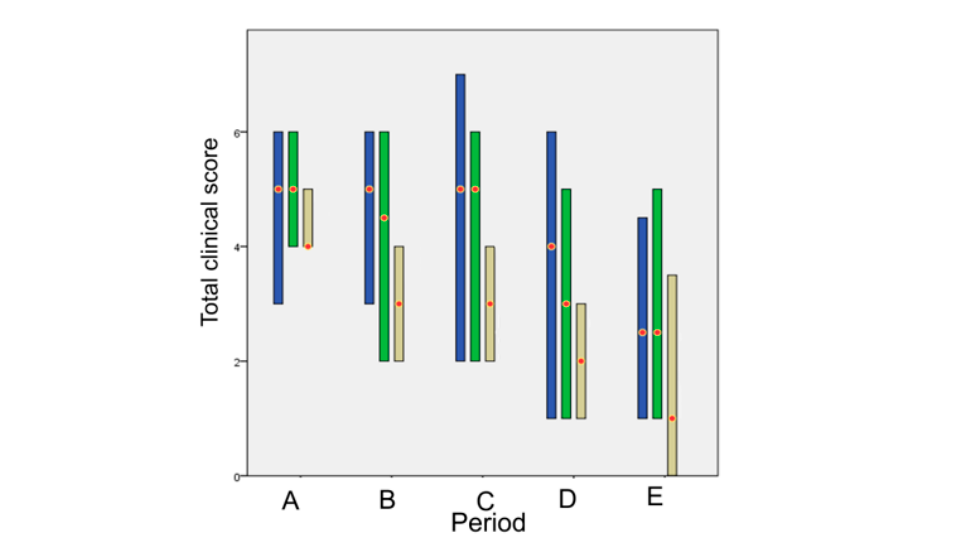
Figure 9. Median (red dot) and interquartile range (column) of total clinical evaluation score for each technique (blue: staples, green: glue, gray: intradermal) in each period. [period A: 1–8 po.d.; period B: 9–21 po.d.; period C: 22–63 po.d.; period D: 64–180 po.d.; period E: 181–365 po.d.]. In period B, staples